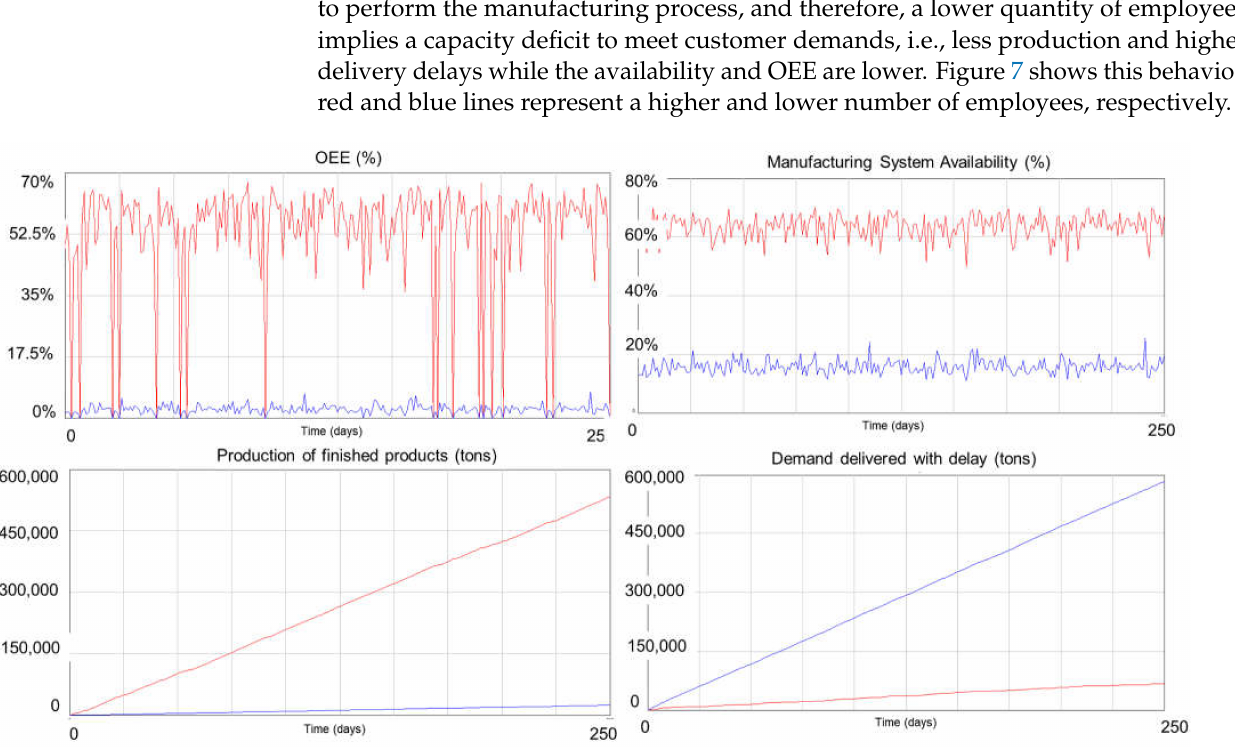
Figure 7. Simulation model validation: number of employees (own